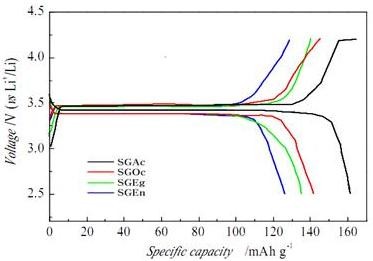
Initial charge-discharge profiles of LiFePO4/C.